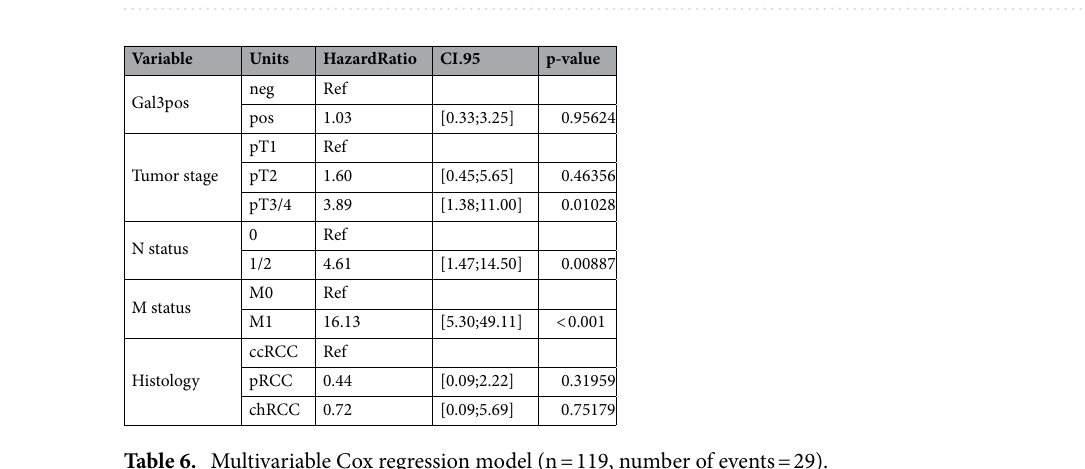
Figure 2. Kaplan–Meier curves for progression-free survival according to ( a ) binary expression of Gal3ST1 (positive vs negative) and ( b ) intensity grades of Gal3ST1 protein expression in our patient cohort.